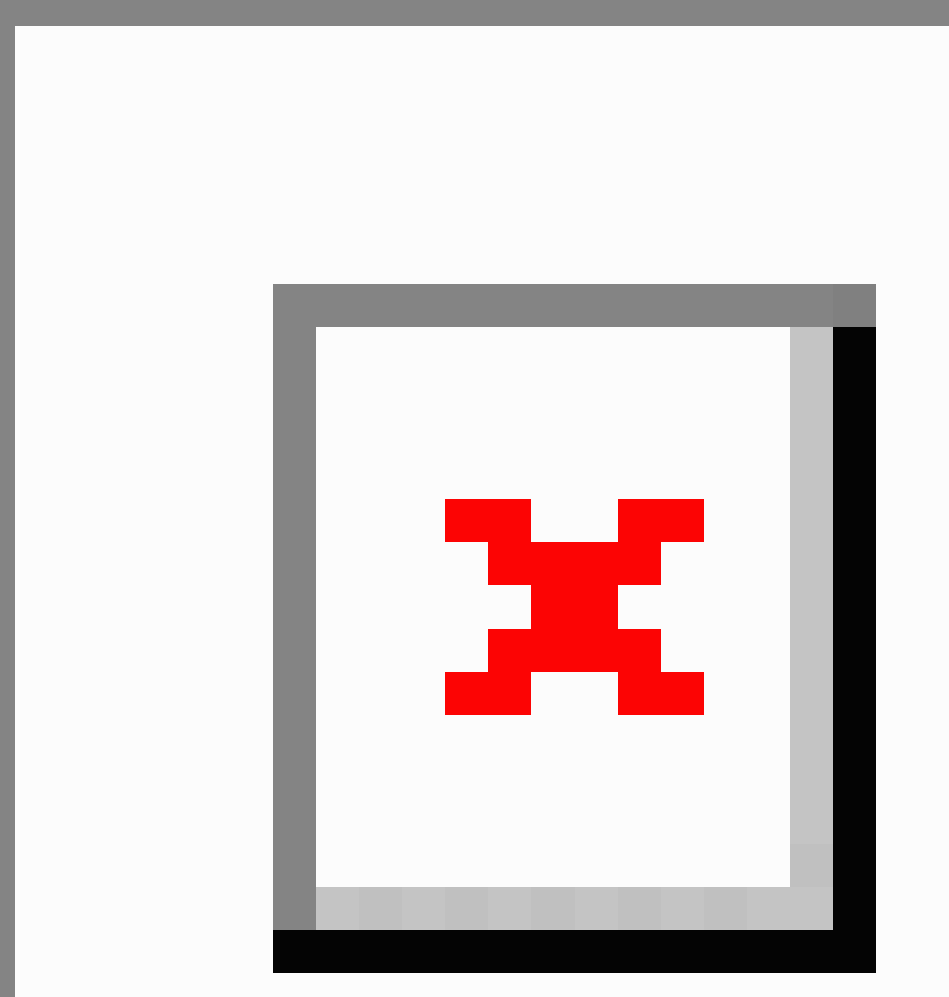
Figure 2. Sample participant feedback. SCRAM: secure continuous remote alcohol